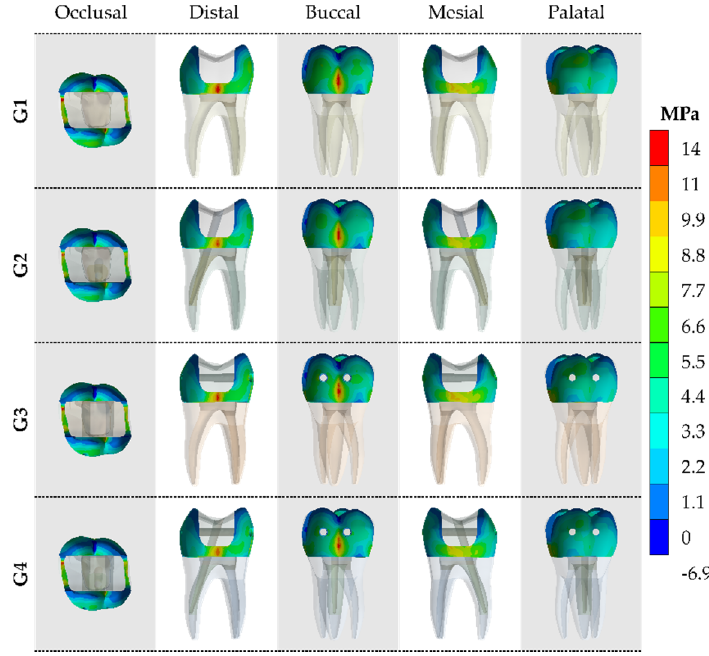
Figure 4. The maximum principal stress (MPa) concentration from five different viewpoints in the enamel tissue according to the GFP treatment.